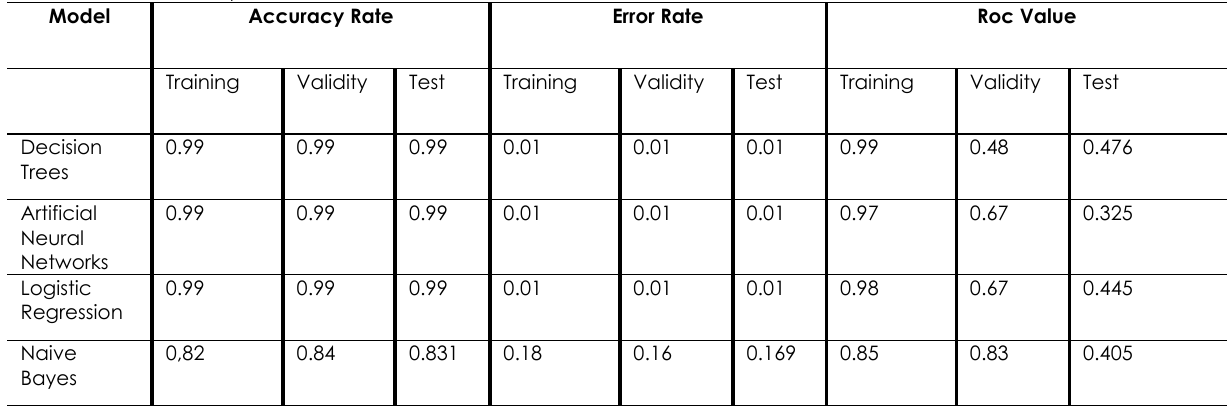
Table 7. Model comparison fit statistics.